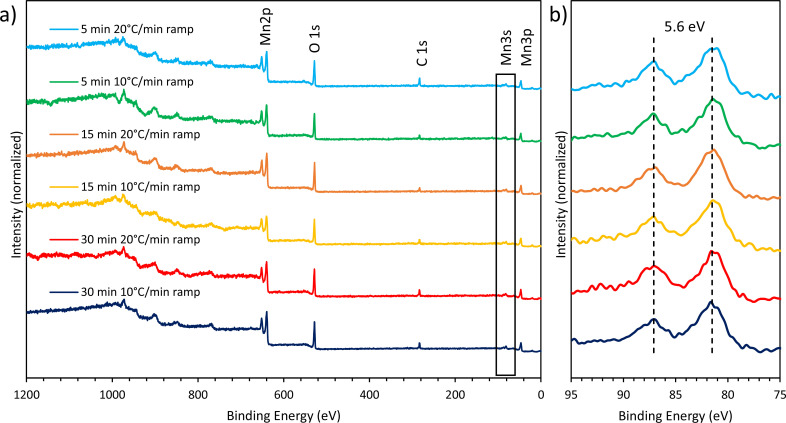
XPS spectra of MnO NP samples for each temperature profile showing the a) whole spectral region and b) the Mn3s region. The whole spectral region indicates the presence of manganese, oxygen, and carbon in the NP samples, while the Mn3s region shows peak splitting characteristic of surface oxidation to Mn3O4 (Mn2+/Mn3+ oxidation states).